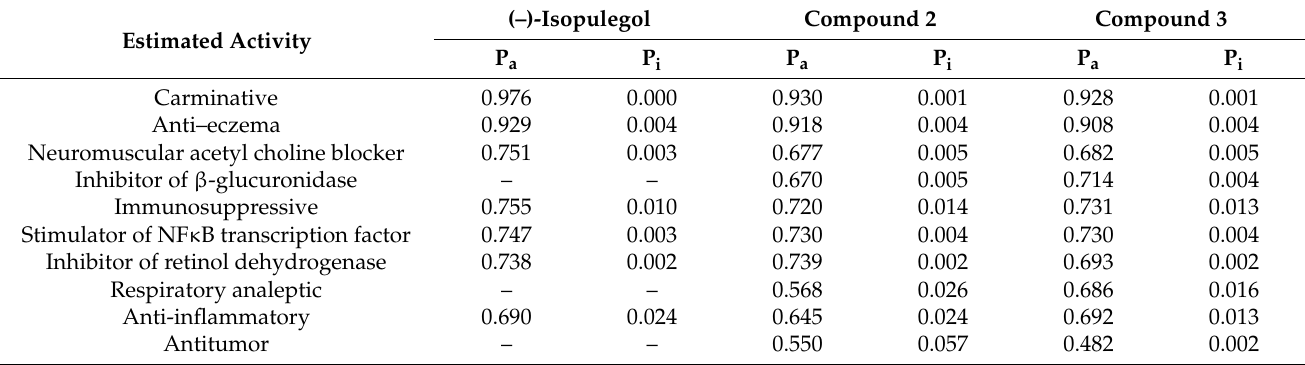
Table 3. Estimated biological activity of (–)-isopulegol and its